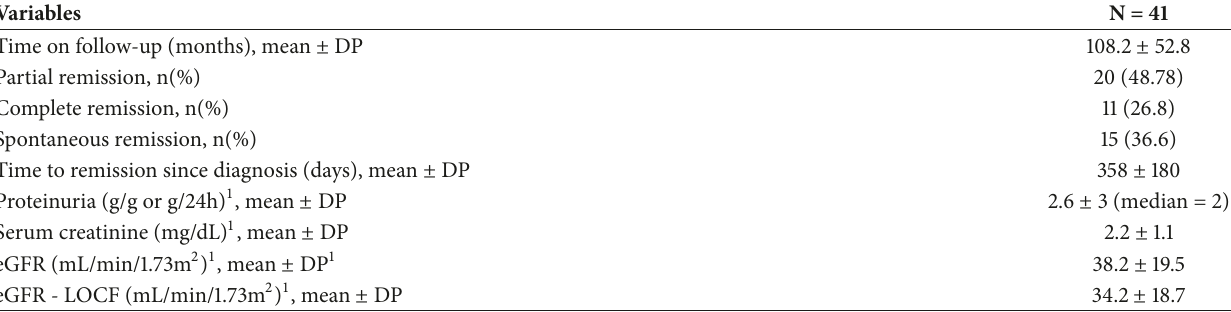
Table 3: Posttransplant MN